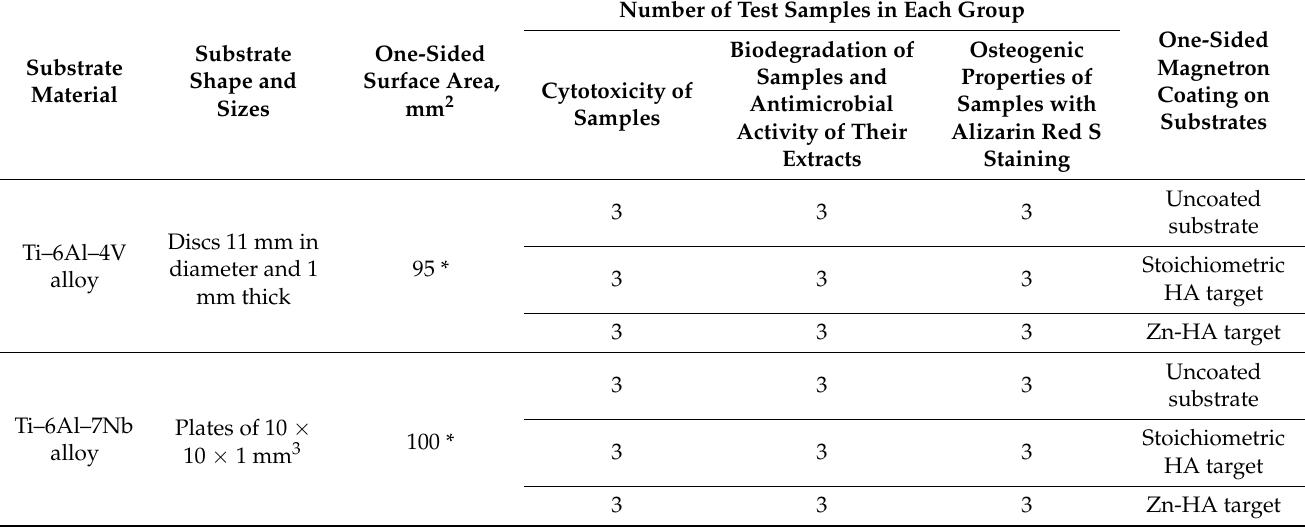
Table 1. Samples for in vitro biomedical